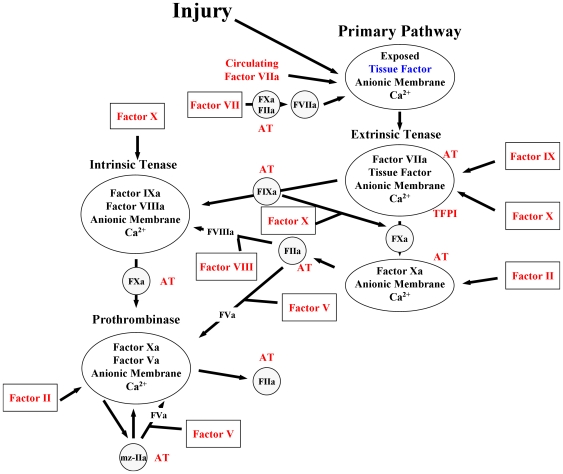
Schematic of the computational model of the tissue factor pathway.The multicomponent processes encompassed in the computational model are illustrated as either: enzymes (open circle), inhibitors (hatched circle), zymogens (open boxes) or complexes (open ovals). Upon injury to the vessel wall, tissue factor, the cofactor for the extrinsic tenase complex, is exposed to circulating factor VIIa and forms the vitamin K dependent complex the extrinsic tenase. Factor IX and factor X are converted to their serine proteases factor IXa (FIXa) and factor Xa (FXa) which then form the intrinsic tenase and the prothrombinase complexes, respectively. The combined actions of the intrinsic and extrinsic tenase and the prothrombinase complexes lead to an explosive burst of the enzyme thrombin (IIa). The procoagulant response is down regulated by the stoichiometric inhibitors tissue factor pathway inhibitor (TFPI) and antithrombin (AT). TFPI serves to attenuate the activity of the extrinsic tenase trigger of coagulation. AT directly inhibits thrombin, FIXa and factor Xa. The proteins in which the concentrations from individual subjects are used are shown in red. Tissue factor in blue is arbitrarily set to 5 pM. Circulating FVIIa is set at 1% of the concentration of FVII from each individual.